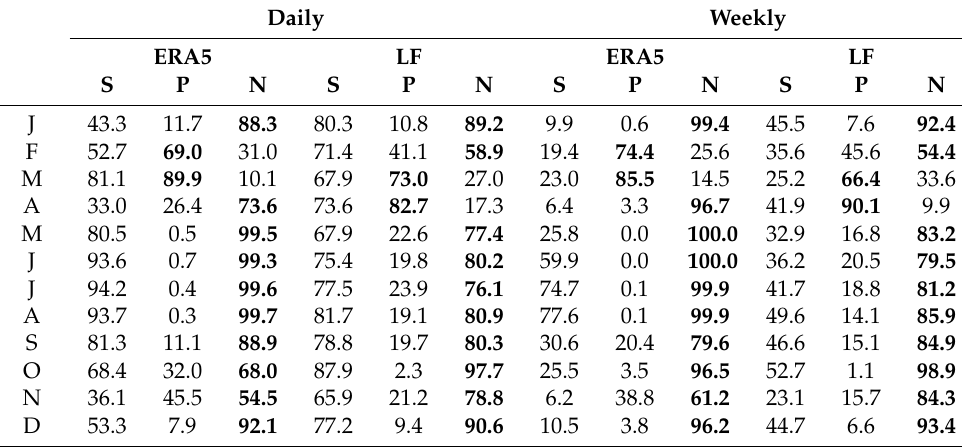
Table 4. Monthly results of the percentage of significant (S), positive (P), and negative (N) trends at daily and weekly scales for the soil water deficit index (SWDI). Maximum trend percentage values are in